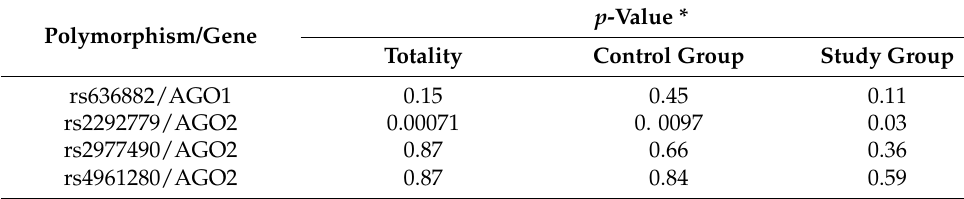
Table 1. Concordance of genotype distribution of the analyzed miRNA gene maturation.